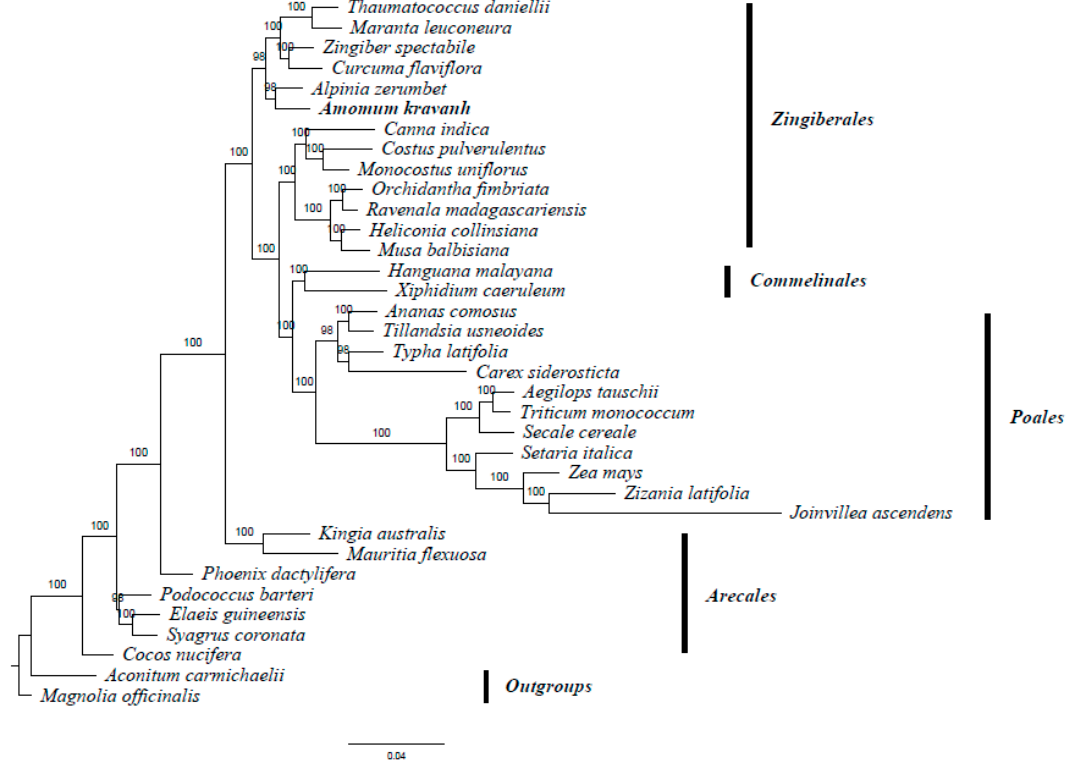
Figure 6. ML phylogenetic tree of 33 taxa in the commelinid clade based on the concatenated sequences of 58 shared chloroplast protein-coding genes. Numbers above each node are ML bootstrap values >50%. Magnolia officinalis and Aconitum carmichaelii were used as outgroups.